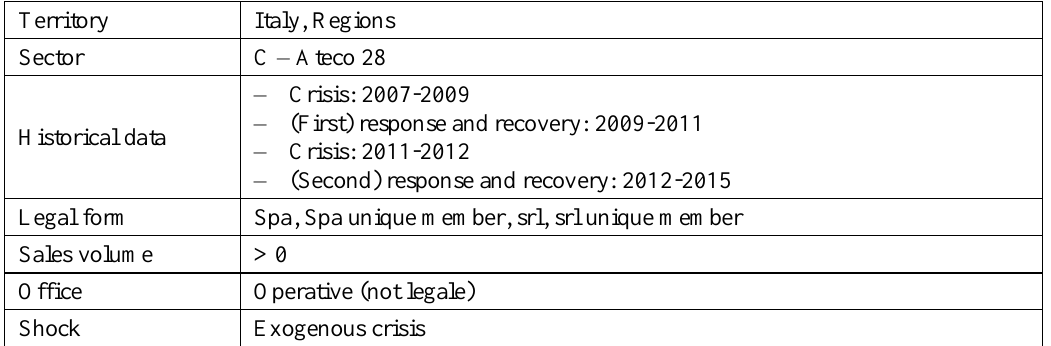
Table 1: Scope of the